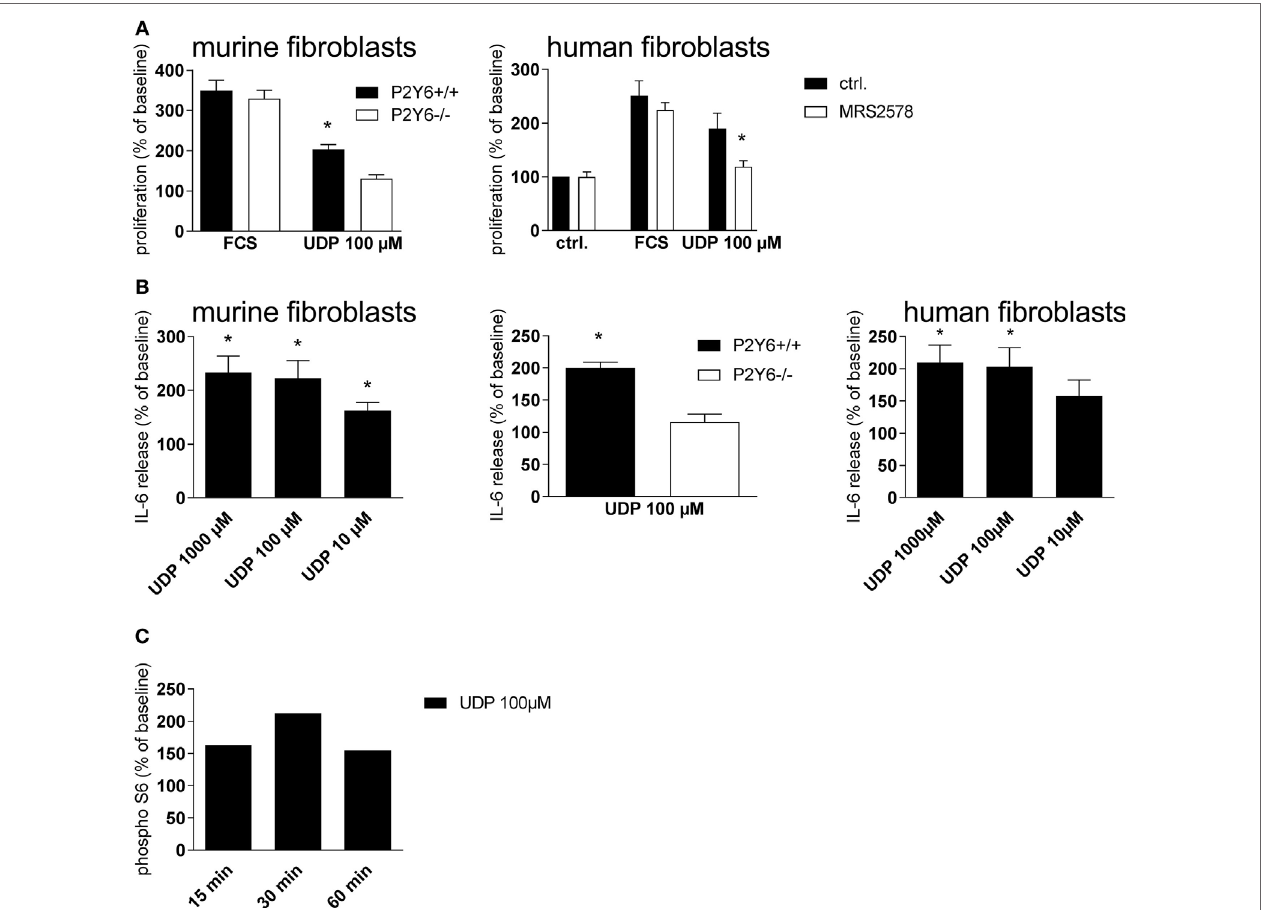
FigUre 7 | P2Y 6 Rs induce proliferation and cytokine secretion of lung fibroblasts. Primary murine lung fibroblasts were generated from wild-type or P2Y 6 R-deficient animals. The proliferation rate after stimulation with uridine-5 ′ -diphosphate (UDP) was determined [ (a) , left panel]. Proliferation rate of human primary lung fibroblasts after pre-incubation with the P2Y 6 R antagonists MRS2578 and stimulation with UDP [ (a) , right panel]. IL-6 release of primary murine [ (B) , left panel and middle] and human [ (B) , right panel] lung fibroblasts stimulated with UDP was measured by ELISA. S6 phosphorylation after stimulation with UDP was measured by Western Blot at the indicated time points. One representative experiment out of three is shown (c) . n = 3–5 per group (* p <